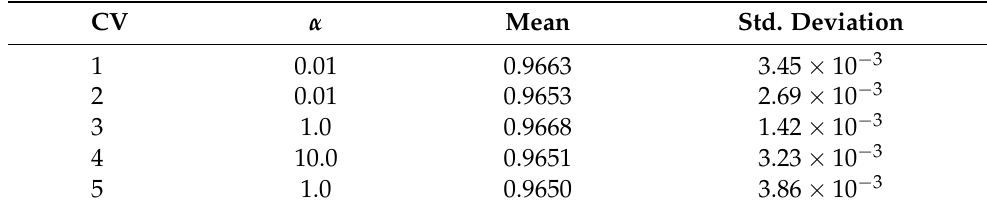
Table 2. Best Naive Bayes model by iteration.